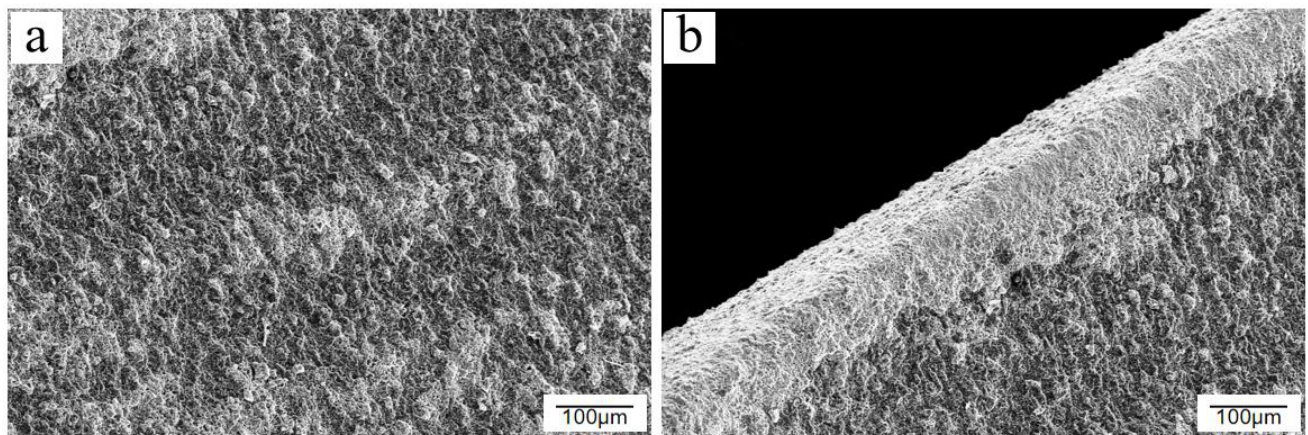
Figure 3. Comparison of samples before and after passivation: ( a ) before passivation and ( b ) after passivation.